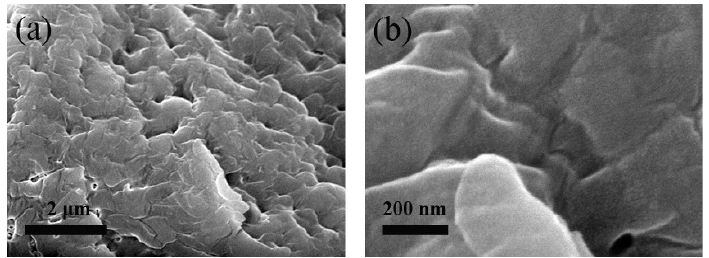
Figure 2. Scanning electron microscope (SEM) images with different magnifications of the residual black solid at the bottom of the inner wall of the quartz tube. Low magnification ( a ), and high magnification ( b